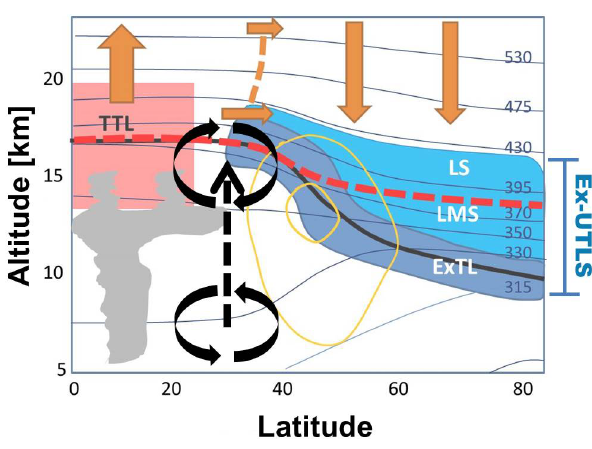
Figure 1. Illustration of the dynamical structure of the UTLS for the northern hemispheric summer adapted from Fig. 2b of Gettel- man et al. (2011) and Fig. 9 of Riese et al. (2014). The thick black line denotes the location of the thermal tropopause. Thin solid lines denote isentropes, and the red dashed line highlights the 380K isen- trope. The location of the TTL is represented in light red. The Ex- UTLS is divided into the extratropical tropopause layer (ExTL) in dark blue and the lowermost (LMS) and lower stratosphere (LS) in light blue. The LMS and LS are separated by the 380K isen- trope. Yellow lines indicate the location of the jet stream. Orange arrows sketch the upward transport of air masses within the TTL and descending air masses in the extratropical stratosphere. Both regions are linked by the deep (upper horizontal arrow) and shal- low (lower horizontal arrow) branch within the stratosphere. The stratospheric residual circulation as a part of the Brewer–Dobson circulation (BDC) can be subdivided into a deep and shallow branch (orange arrows). The location of the Asian monsoon circulation is schematically shown in